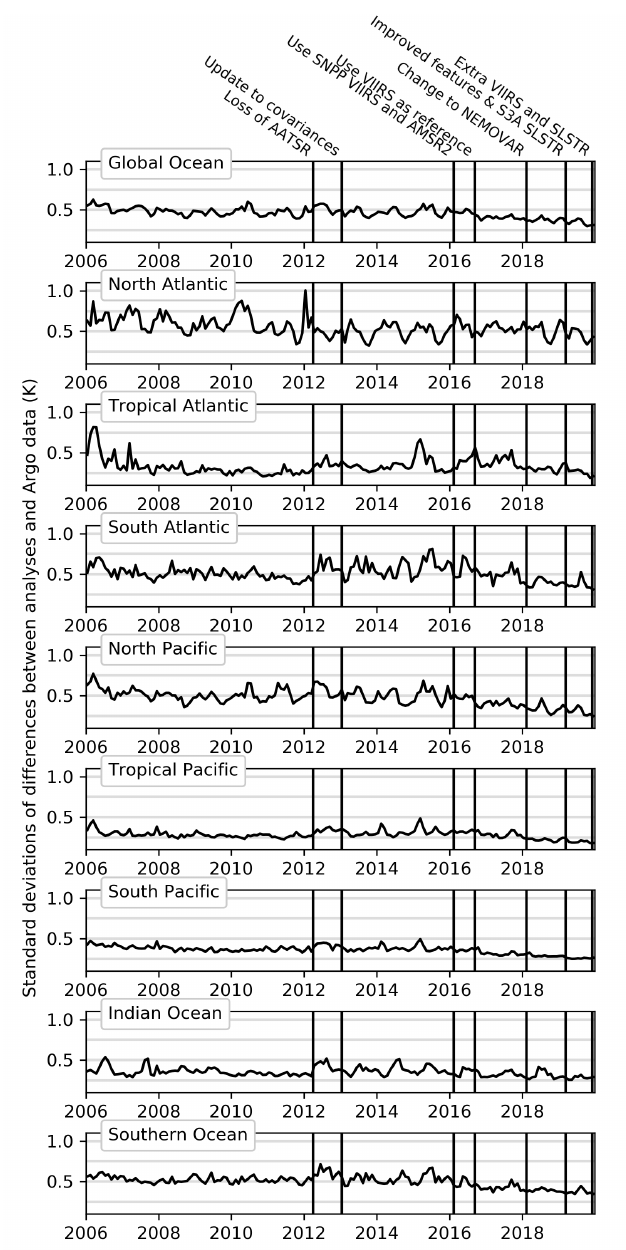
Figure 11. Monthly standard deviations of differences between near-surface Argo data and OSTIA foundation SST analyses for different regions. Some of the most notable changes to the OSTIA system are marked by vertical lines. Grey horizontal lines are drawn to aid comparison of the performance of OSTIA at different